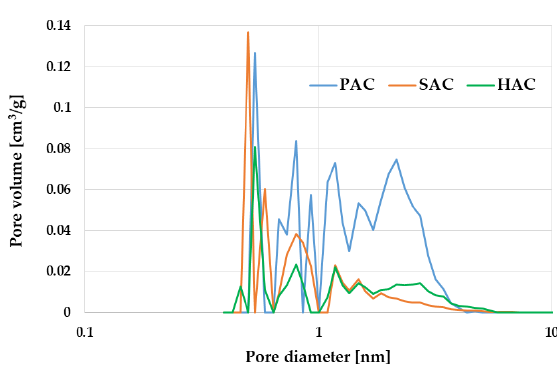
Figure 2. Pore size distribution of PAC, SAC and HAC activated biocarbons.